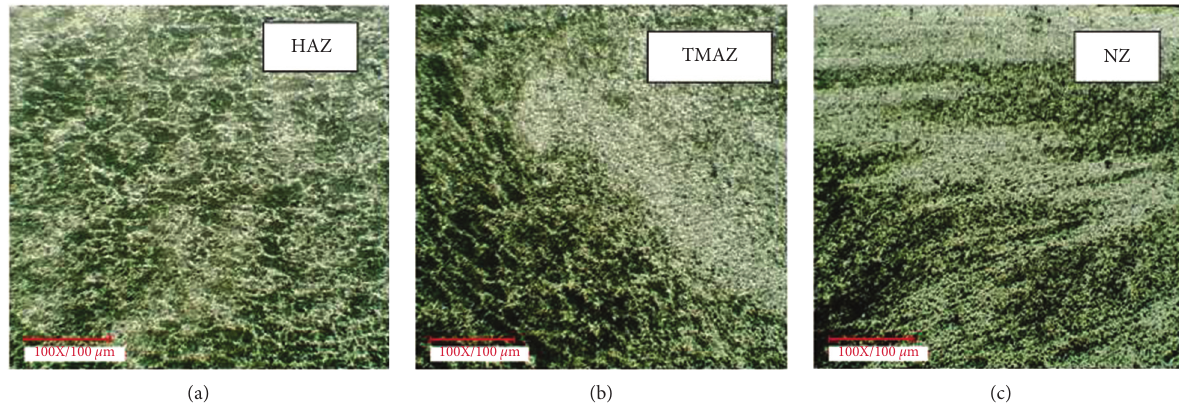
Figure 12: (a–c) Microstructure of cross section of bead-on-plate processed specimen at a tool spinning speed of 1200rpm, traverse speed of 20mm/min, and axial load of